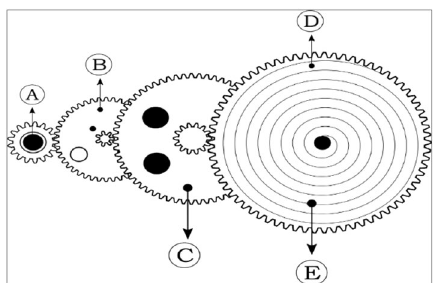
Fig. 2 Winding gear train the CITIZEN8200A Caliber. A The oscillating weight or the rotor, B Pawl Winding Wheel, C Reduction Wheel, D Ratchet Wheel, E Mainspring, contained in the barrel (attached to the Ratchet